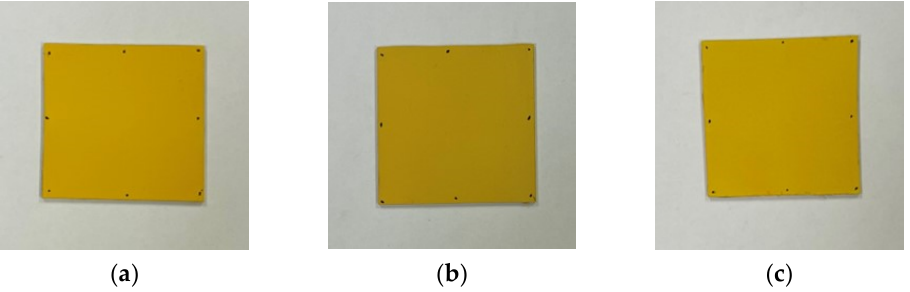
Figure 2. Pictures of TSP test pieces. ( a ) PAA + EtOH ( C = 100.0 mg/g); ( b ) PMMA + EtOH + Toluene ( C = 102.6 mg/g); ( c ) PMMA + EtOH + DCM ( C = 85.4 mg/g).